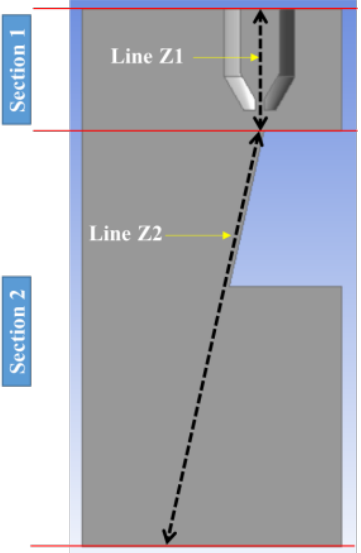
Figure 8. Sections showing lines Z1 and Z2, where the flow field distribution was studied. The effect of nozzle diameter and kerf geometry on the behavior of gas flow was assessed through the pressure and velocity distribution along the kerf slot in the symmetry plane for all the cases discussed in Section 3. Figure 9 shows the pressure distribution along the symmetry plane of the computational domain. Similarly, Figure 10 represents the velocity distribution. In addition to the flow distribution along the kerf slot, the flow deflection along the top surface of the cutting sample was examined using a velocity map. Figure 11 shows the velocity distribution along the top surface of the cutting sample. The gas flow through all the nozzles showed an under-expansion flow. This behav- ior is common for high-pressure flows in conical subsonic nozzles such as those being investigated in this study. The flow distribution along the nozzle and kerf slot for all cases showed uniformity and a good flow distribution. The pressure distribution along the flow direction exhibited oscillation that dampened as the flow propagated further downstream. The frequent oscillation inside the kerf slot near the top surface indicates the presence of an oblique shock wave. Further downstream, the flow exhibits periodic oscillation that dampens as the flow propagates away from the nozzle. This is due to the presence of shock structures along the flow propagation direction, as observed in the Schlieren experiment. The velocity field shows a similar oscillation in the flow indicating an interrelation between the velocity and pressure